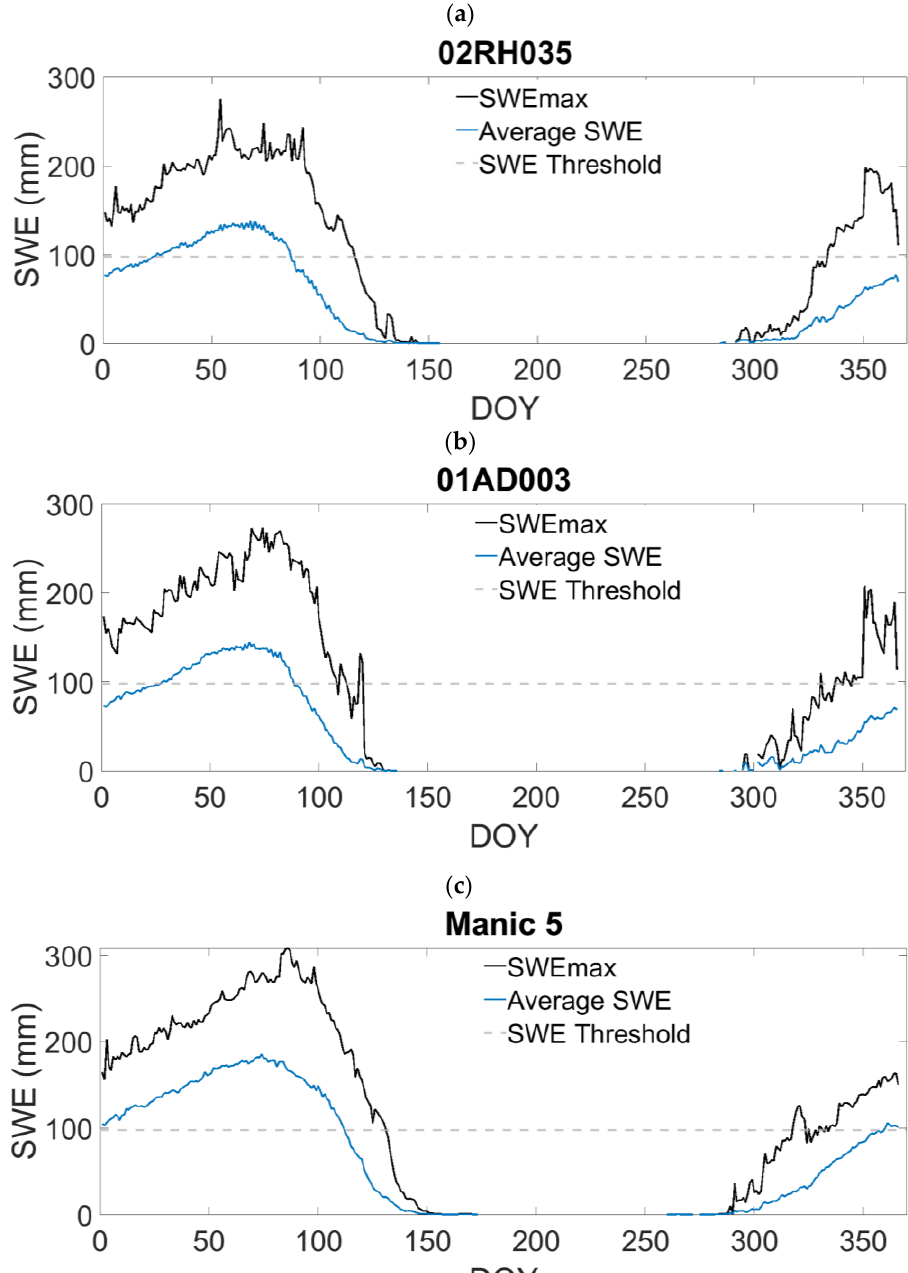
Figure 4. Watershed scale SWE retrieved from GlobSnow: ( a ) 02RH035 (Rivière des Écorces), ( b ) 01AD003 (St-Francis), and ( c ) Manic 5 watersheds. Blue line: average SWE; black line: maximum SWE. Table 2. GlobSnow and in situ seasonal maximum SWE max data.